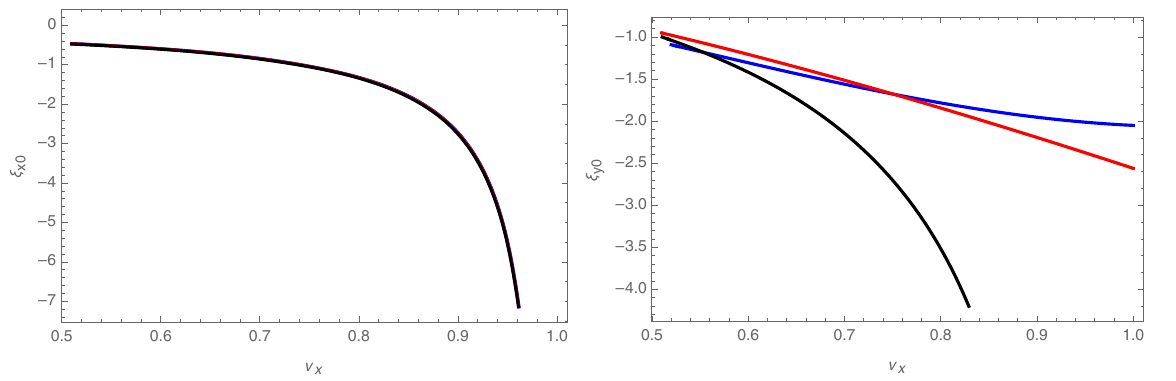
FIG. 9. The natural chromaticity in the horizontal (left) and vertical (right) planes as a function of the betatron tunes with various ∶ ν 1 ∶ 4 , 1:3, and 1 ∶ 2 represented by blue, red, and black color respectively. ratios: ν y x ¼